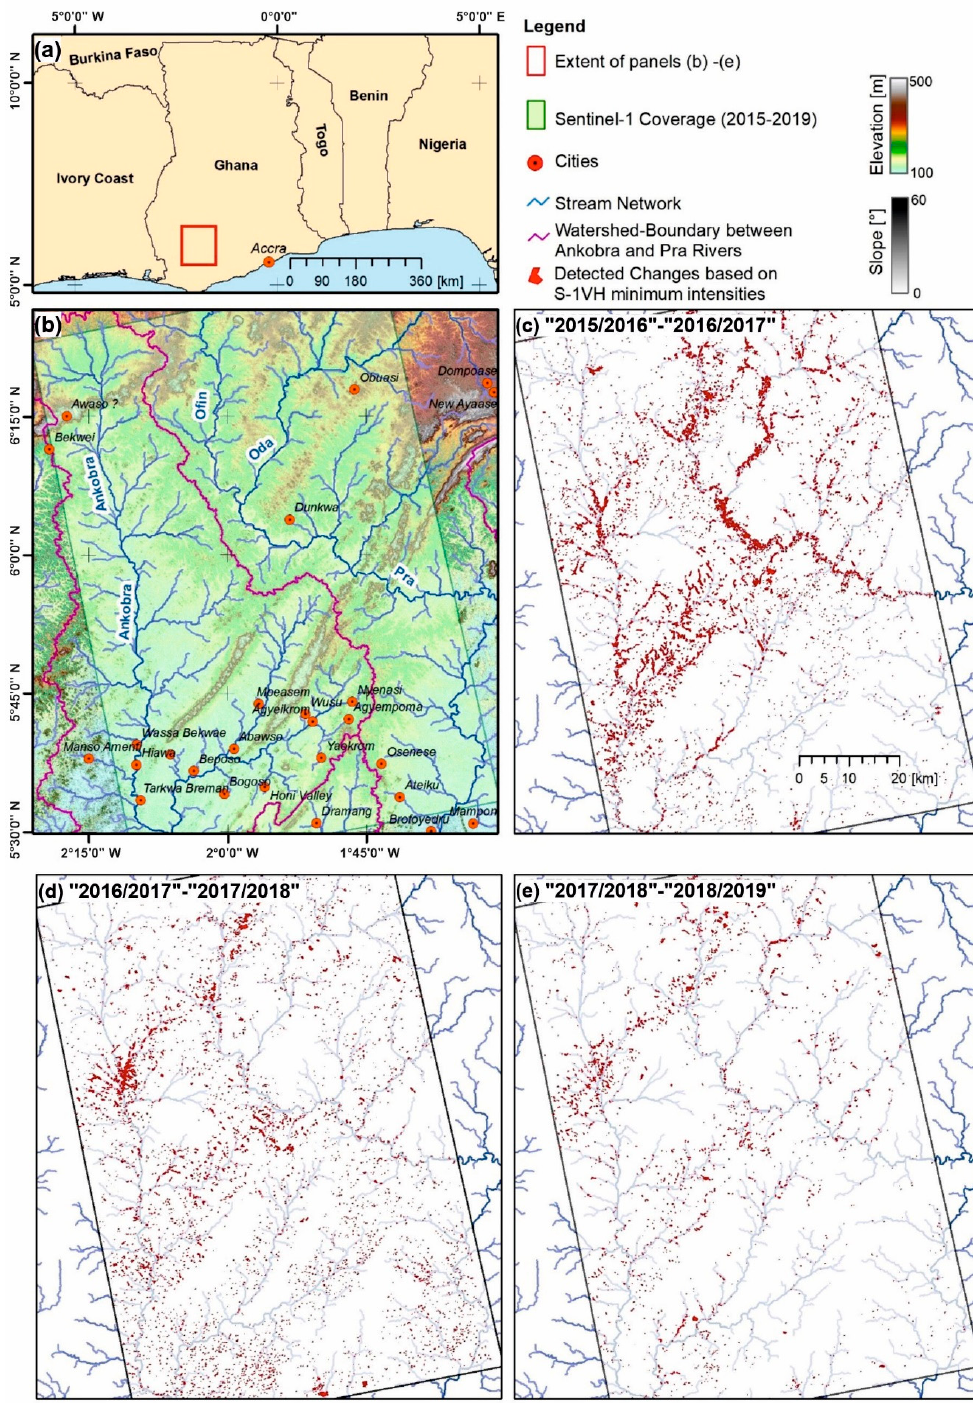
Figure 9. Classification of changes using VH polarization, the minimum intensity (time series feature) and the threshold from histogram intersection (+1.65 dB): ( a ) regional overview; ( b ) topographic and hydrographic setting (based on SRTM DEM), major cities and coverage of Sentinel-1 time series (2015–2019), ( c ) change map "2015/2016"–"2016/2017", ( d ) change map "2016/2017"–"2017/2018" and ( e ) change map "2017/2018"–"2018/2019".